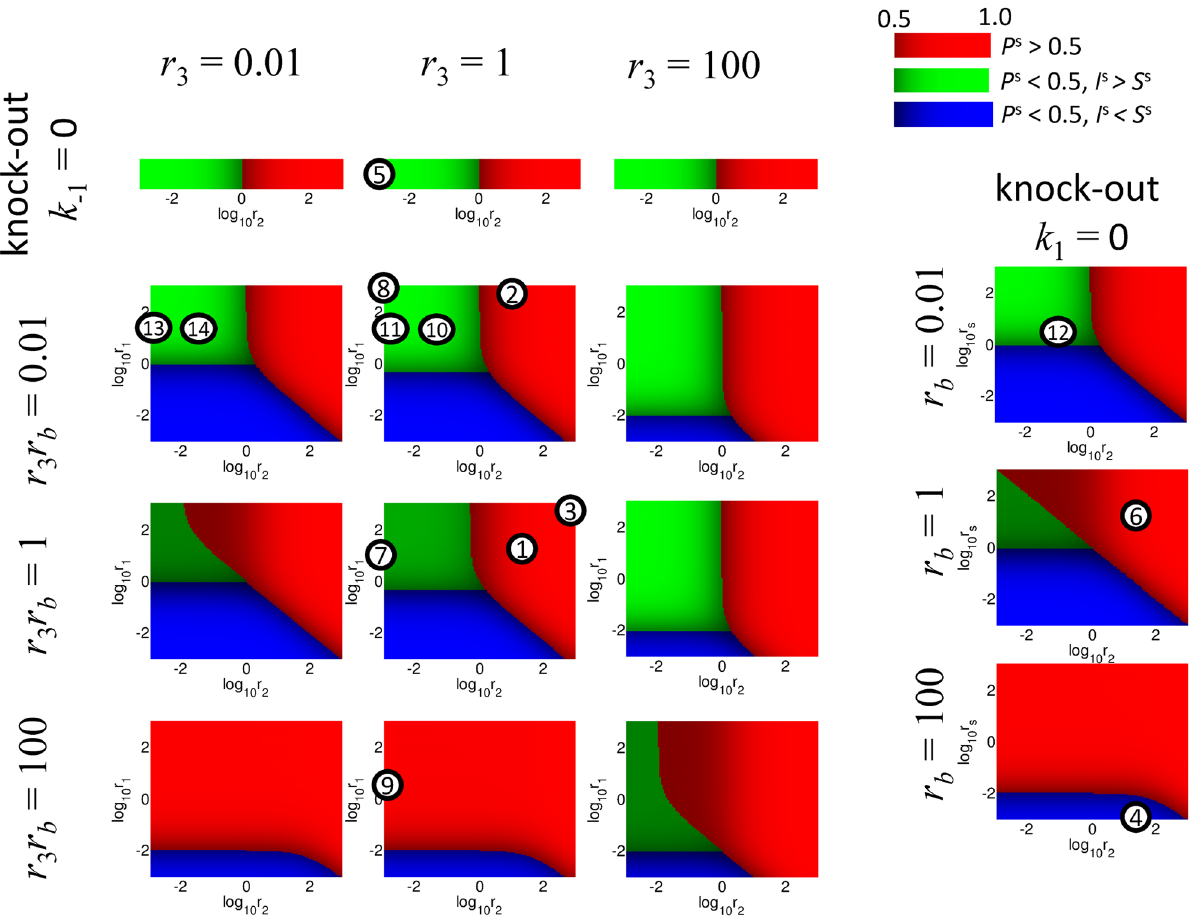
Figure 5. Visualization of the steady states for the toy model in dependence of various parameters. The phase diagrams ( r 2 6 r 1 plane) show the qualitative behavior for small, intermediate and large values of the model parameters. Red color corresponds to the state for which P s . 0.5 (DNA is repaired with probability . 50%). If P s , 0.5 then the color is chosen as green if the probability of trapping in the intermediate state ( I ) is bigger than the propability of the initial unrepaired state ( S ), and as blue in the opposite case. The case k 1 =0 (F1 Q ) is represented separately on the right. In k 3 is used instead of r 1 for the phase plane. The case k 2 1 =0 (R1 Q ) is treated separately on the top and only the r 2 this case, another parameter r s : k { 1 value is varied. The 14 model simulations listed in Figure 6 are shown by the circled numbers in the position of the chosen parameters. 12; Figure S4 in Text S1), as repair is carried out by the (Figure 5 case 9; Figure 7, row 9; Figure S4 in Text S1). The compensatory pathway (state C ). The modeling illustrates how a modeling predicts that this will accelerate the backward reactions, defect in an early HR gene such as RAD51 , BRCA2 , RAD52 , or the favor the compensatory route and increase repair of damaged RAD51 paralogs would provide a selective advantage in cells DNA by the compensatory pathway (state C ). The modeling also overexpressing enzymes of the R2 backward reaction (yeast Mph1, highlights the benefit of reversibility. In Figure 7 (row 8), a human RTEL1 or FANCM). decrease in reversibility (10-fold reduction in R1) leads to significantly less repaired product in mutants that block the downstream step (F2). Complete inhibition of the R1 step leads to wrpSL in cells lacking F2, such as RAD54B-deficient cells (Figure 5 Figure 7, row 13; Figure S4 in Text S1). This suggests that case 8; Figure 7, row 8; Figure S4 in Text S1, see above). The inhibition of F2 (for example RAD54/RAD54B) would be modeling suggests that cells deficient in the downstream forward reaction (F2, e.g. RAD54B 2 / 2 ) are potentially under selective pressure to strengthen the upstream backward reaction (R1, e.g. overexpression of FBH1, FANCJ, or RECQ5). modeling.